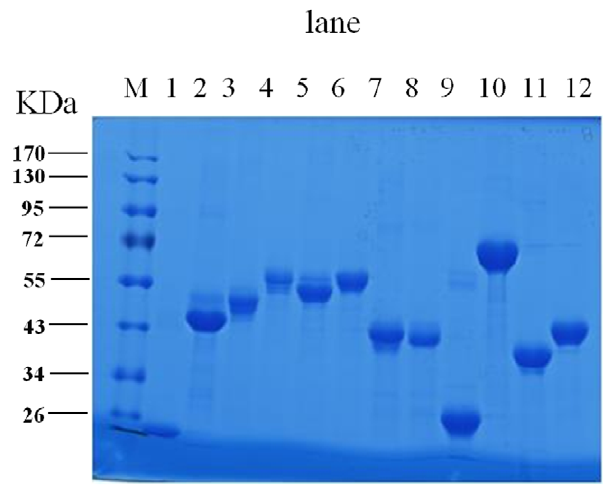
Figure 1. SDS-PAGE of the recombinant proteins. The expression of recombinant fusion proteins were analyzed by SDS-PAGE. M, molecular size protein markers; lane 1–12, the purified fusion proteins: BAB1_0063, BAB1_0116, BAB1_0381, BAB1_0512,